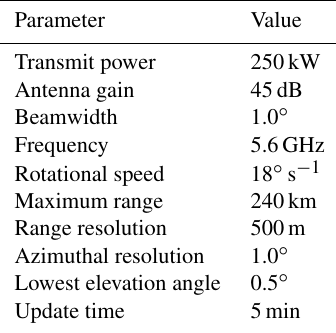
Table 2. Some of the technical parameters used by the Swedish weather radar systems.